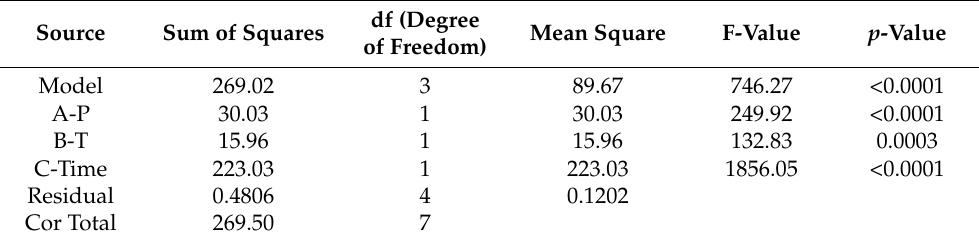
Table 4. Analysis of variance (ANOVA) for the model fitted to the SC-CO 2 impregnation process. Source Sum of Squares df (Degree of Freedom) Model 269.02